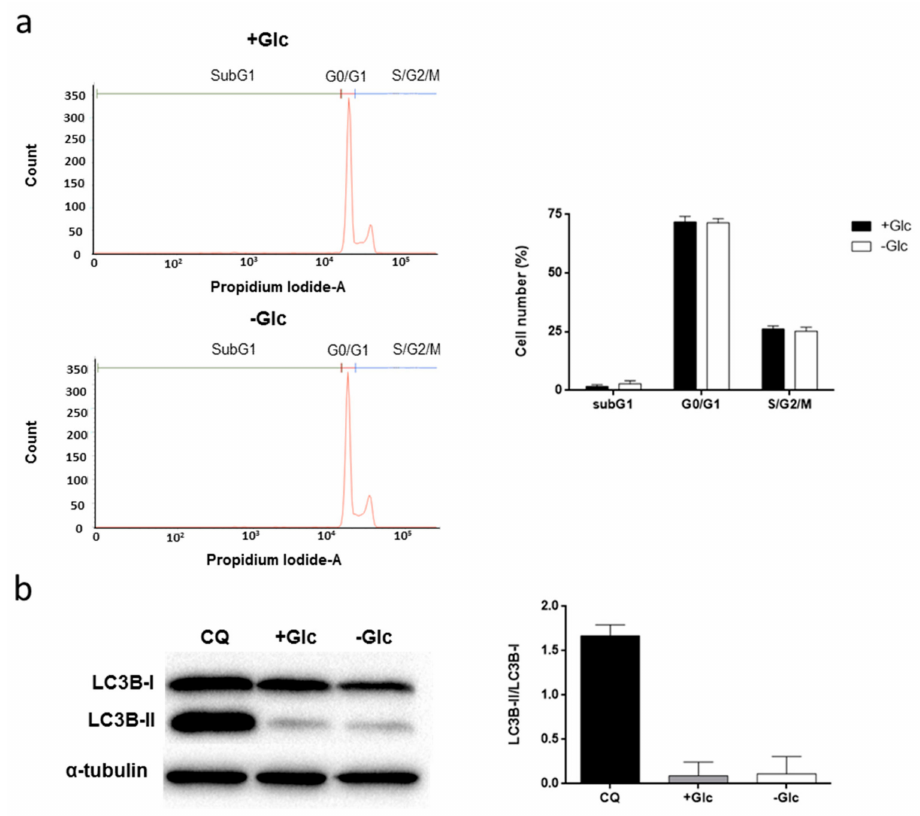
Figure 4. E ff ect of glucose starvation on cell cycle distribution and autophagy. ( a ) Cell cycle distribution of subpopulations of HMEC grown in the presence or absence of 5 mM glucose for 48 h, stained with propidium iodide and percentage of subG1, G1 and S / G2 / M cells were determined using a FACS VERSE TM cytometer. ( b ) LC3B-I and LC3B-II protein expression were measured by Western blot in cells grown in the presence or absence of 5 mM glucose. A positive control incubating cells with 5 mM glucose and 50 µ M chloroquine (CQ) for 16 h was included. Data from Western blot are normalized against α -tubulin expression. Data are expressed as means ± SD of three independent experiments. Glutamine was added to the media in all experiments.